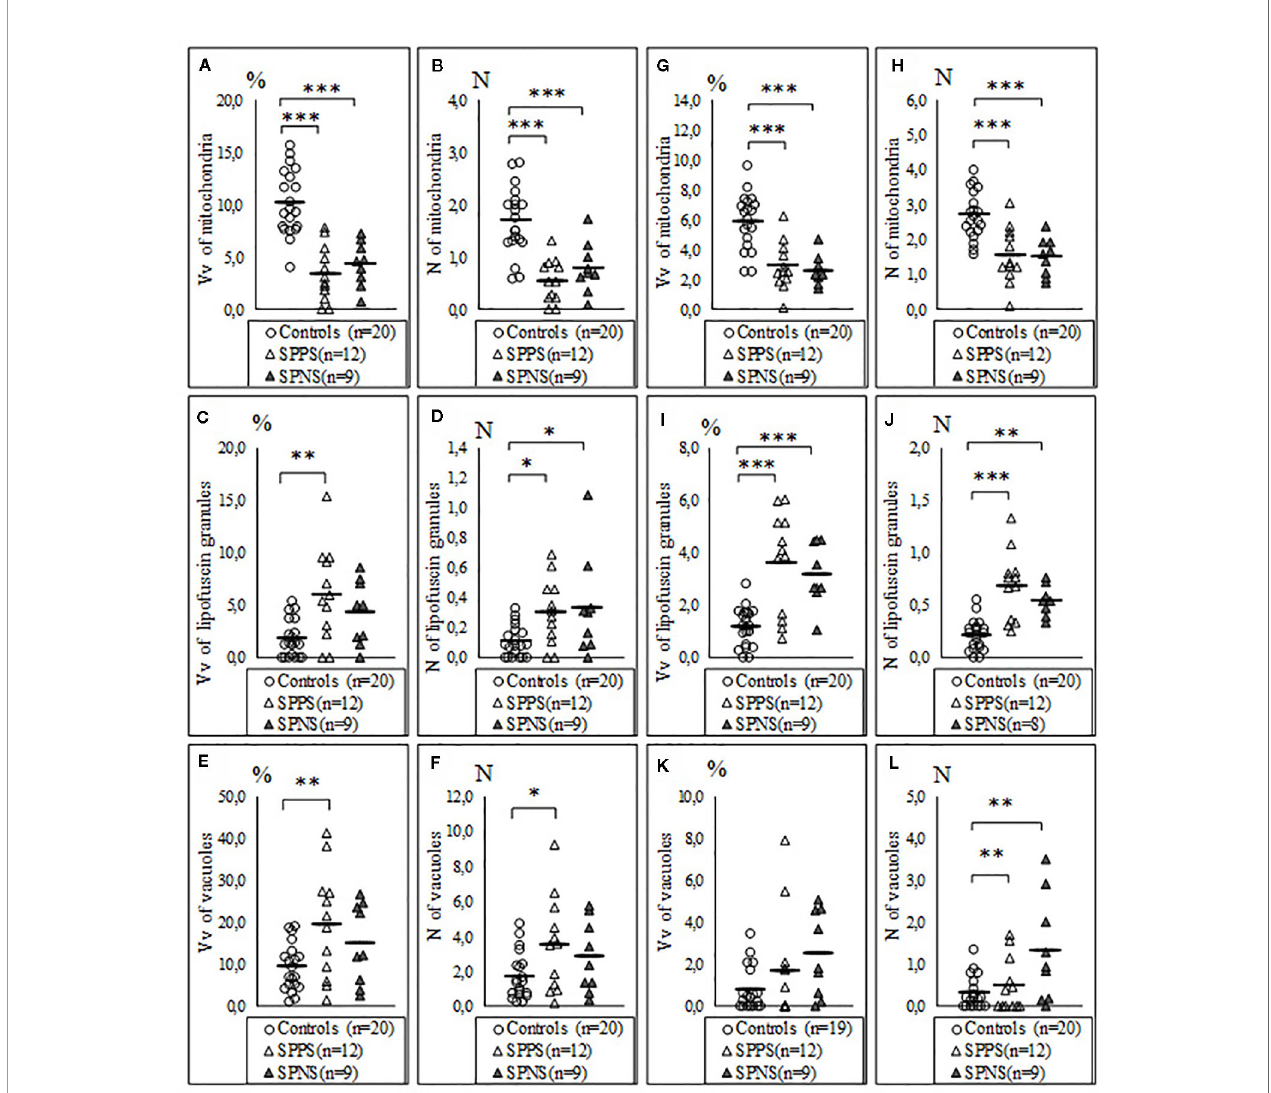
FIGURE 3 | Individual and mean values for Vv and N of mitochondria (A, B) , lipofuscin granules (C, D) , vacuoles (E, F) in microglia adjacent to oligodendrocytes, in oligodendrocytes adjacent to microglia (G – L) for the control group, the subgroup with predominantly positive symptoms (SPPS) and the subgroup with predominantly negative symptoms (SPNS). *p < 0.05, **p < 0.01, ***p <